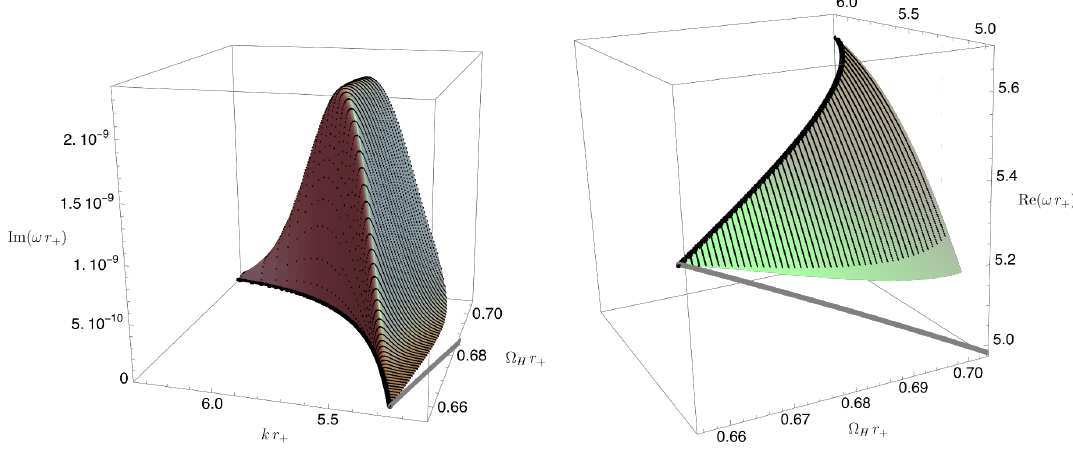
Figure 8 . Frequency for m = 4 unstable superradiant modes, as a function of parameters of √ Myers-Perry black strings. The instability is present (i.e. Im ω > 0 ) for e Ω H | c 00 ≤ e Ω H ≤ 1 / 2 , with e , and e k ? ( e Ω H ) ≤ e k ≤ e k ( e Ω H ) . The zero mode curve e k ( e Ω H ) (and Im ω = 0 ) was e Ω H | c 00 = 7 √ e (0) (0) 113 computed independently (see c 00 A 00 ) in figure 6 and we show it here as a continuous black line in the Im ω = 0 plane. On the other hand, the gray curve represents the line e k ? ( e Ω H ) as defined e parametrically in (4.12) for m = 4 (i.e. the cutoff curve c 00 B 00 in figure 6). It meets the zero mode black curve at e Ω H | c 00 . It is very difficult to obtain solutions in the neighborhood of the cutoff gray line e k ? ( e Ω H ) so we do not attempt to find them in the present m = 4 case; hence we find a gap between when the surface approaches this gray